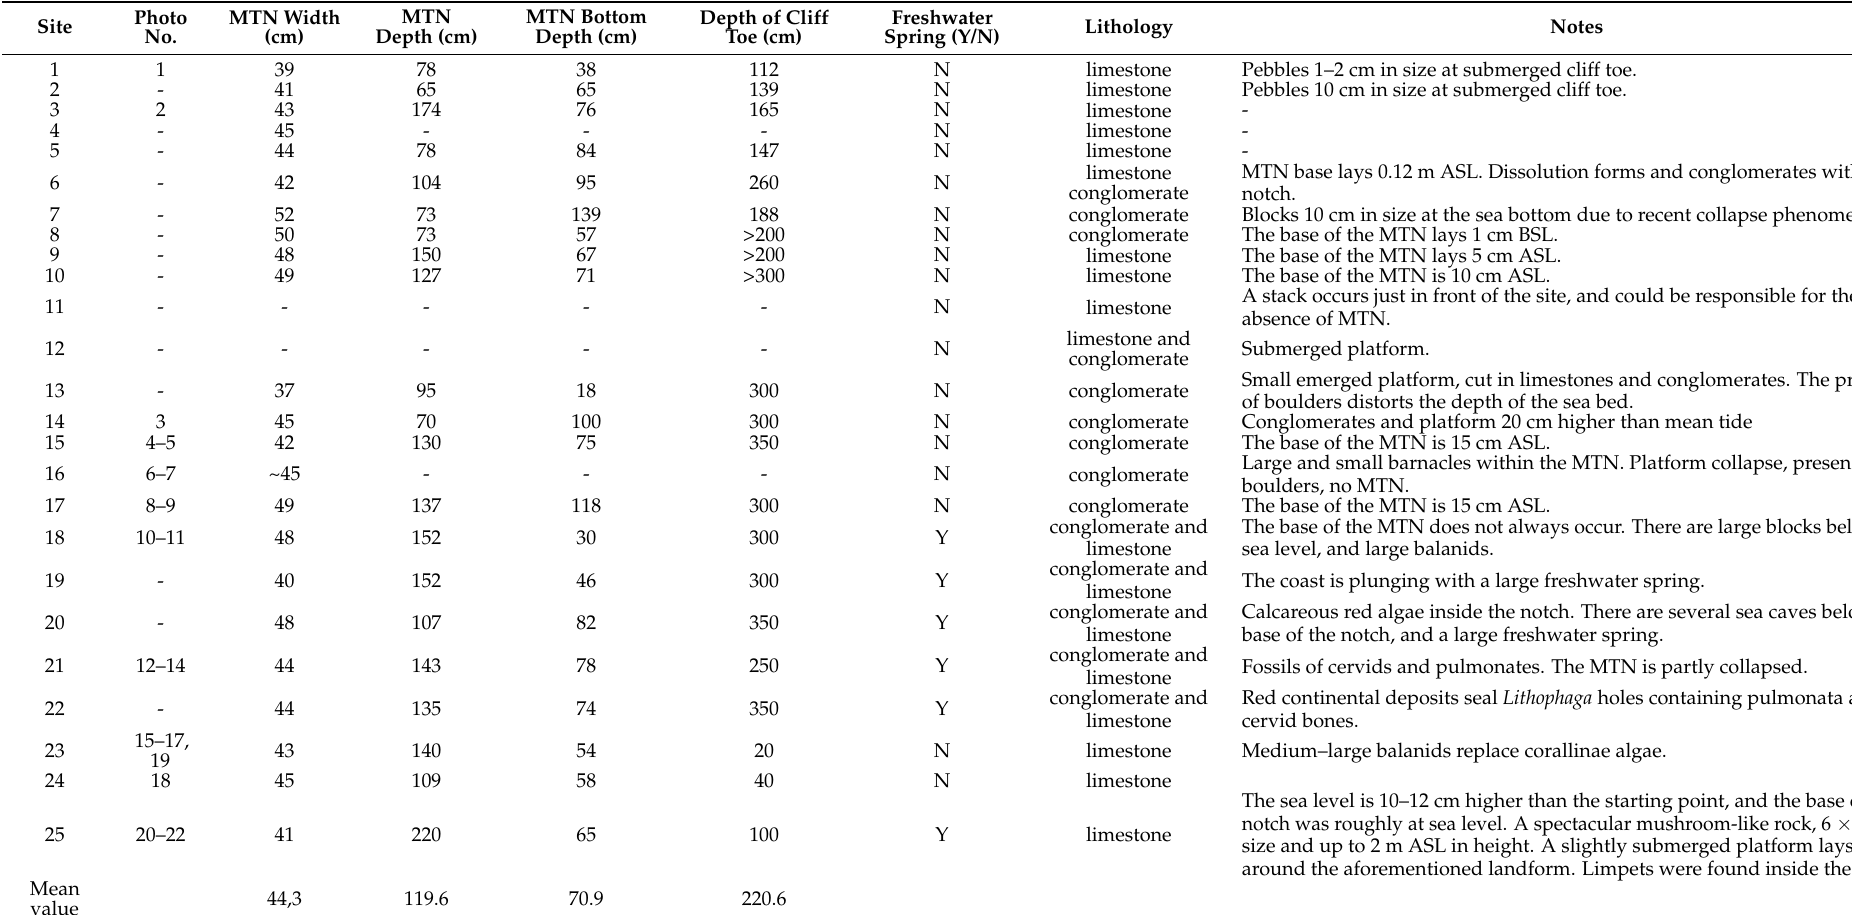
Table 3. The morphometric parametres of MTNs in the short stretch at the Arenella harbour